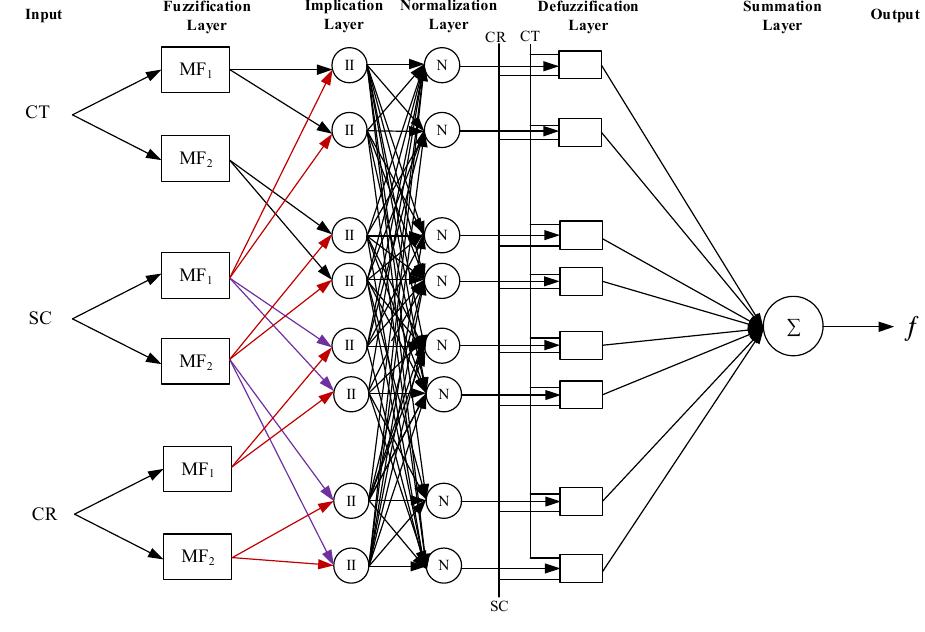
Figure 7. The ANFIS network-based architecture. Table 3. ANFIS-GA model’s analytical